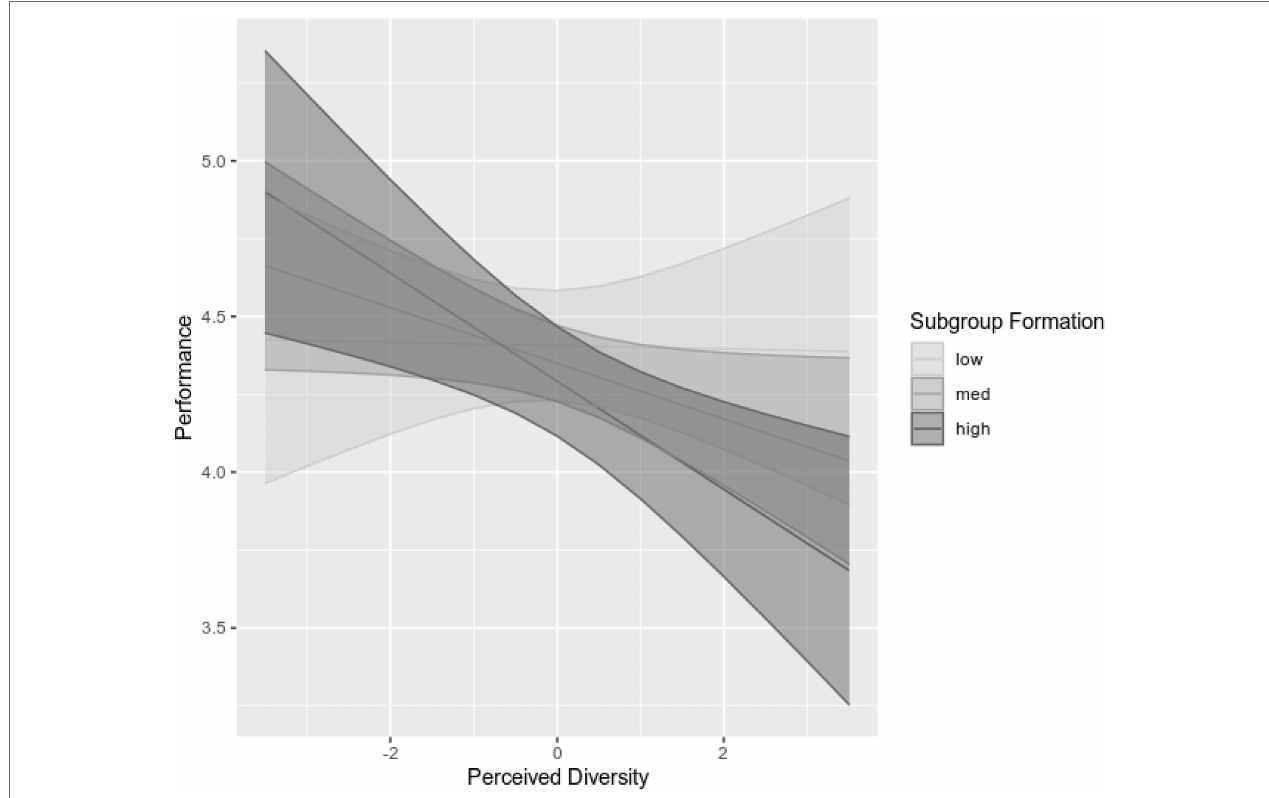
FIGURE 2 | The relationship between perceived diversity and performance at low, medium, and high levels of subgroup formation. 95%-confidence intervals are depicted around the